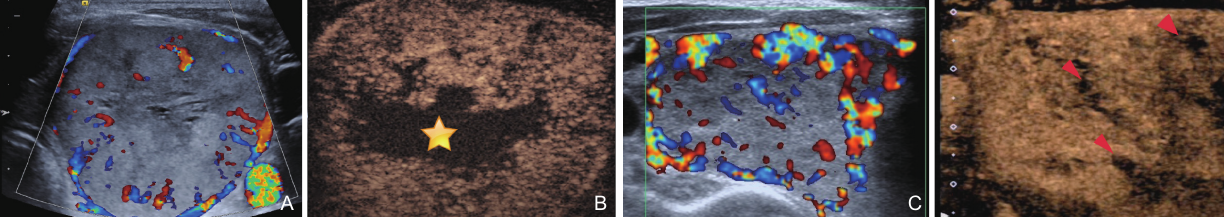
A Figure 4 The comparison of the perfusion defect in FA and in FTC. (A) Transverse sonography of the left thyroid from a 71-year-oldman with widely invasive FTC, the color Doppler shows abundant intra-nodular blood flow; (B) CEUS image shows regional filling defect (asterisk) in peak phase; (C) Transverse sonography of the right thyroid from a 74-year-old woman with FA, the color Doppler shows abundant intra-nodular blood flow; (D) CEUS image shows patchy filling defect (red arrows) in peak phase.